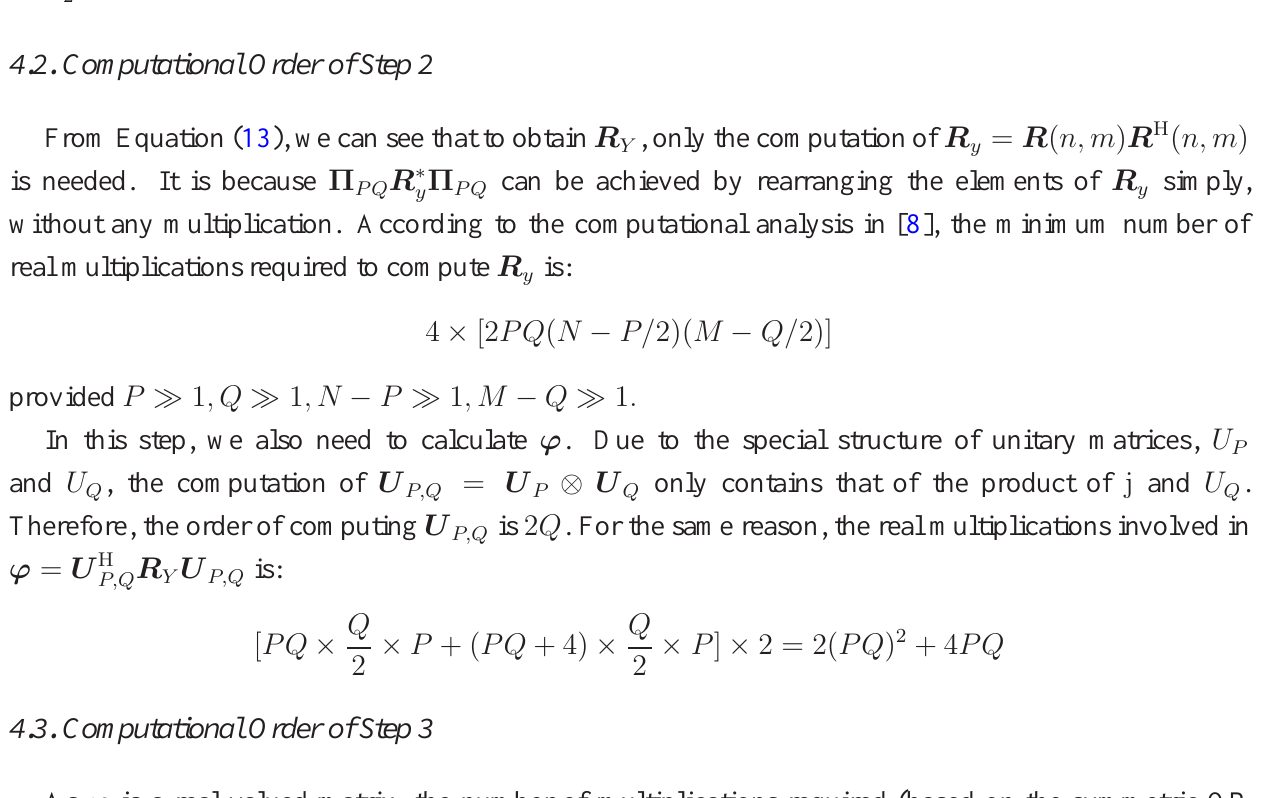
Table 1. Real multiplications involved in the computations of Υ